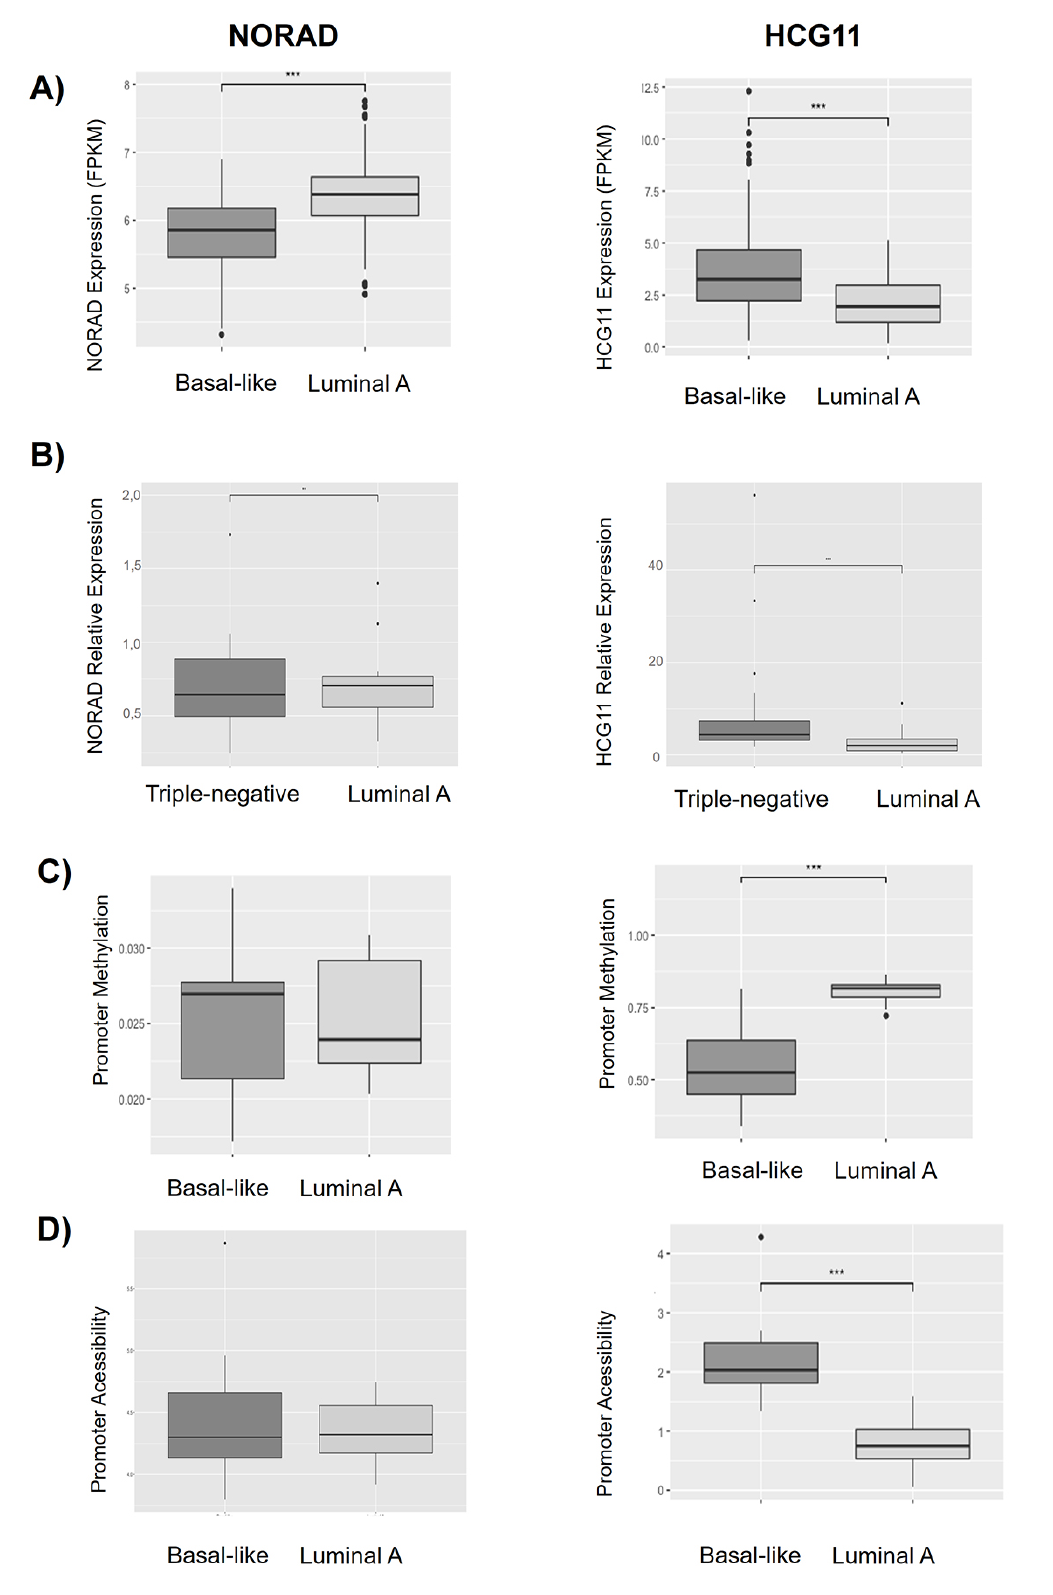
Figure 1 – NORAD and HCG11 presented different expression patterns in BC subtypes. (A) Analyzing TCGA cohort on luminal A (n = 231) and basal- like (n = 98) subtypes, NORAD was upregulated in Luminal A while HCG11 was upregulated in basal-like subtype. (B) Relative expression measured by RT-qPCR on luminal A (n = 21) and triple-negative (n = 23) Brazilian BC samples, NORAD and HCG11 maintained the pattern of expression observed in TCGA cohort. (C) TCGA cohort data for promoter methylation. HCG11 presented in Luminal A subtype greater promoter methylation. (D) TCGA cohort data for promoter accessibility was performed by assay for transposase-accessible chromatin with high-throughput sequencing (ATAC-seq). HCG11 exhibited a more accessible promoter in Basal-like subtype. * p < 0.05; ** p < 0.01; *** p < 0.001; N.S – Not